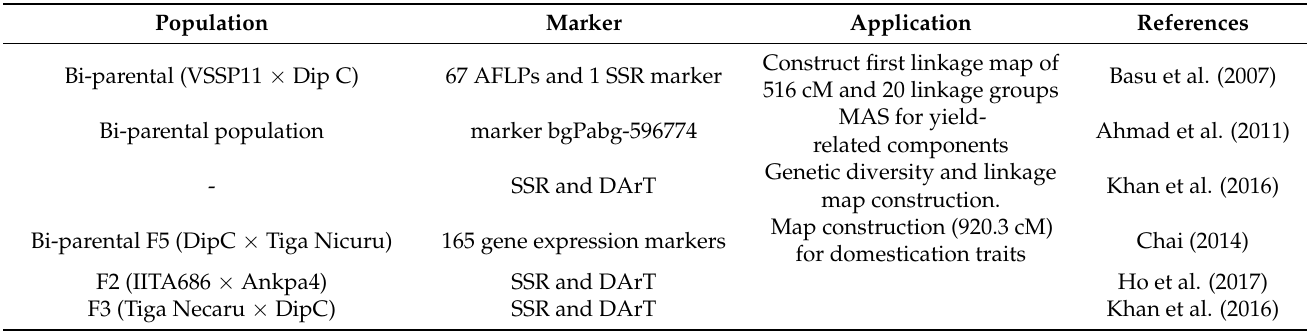
Table 3. Selected marker systems and applications in bambara